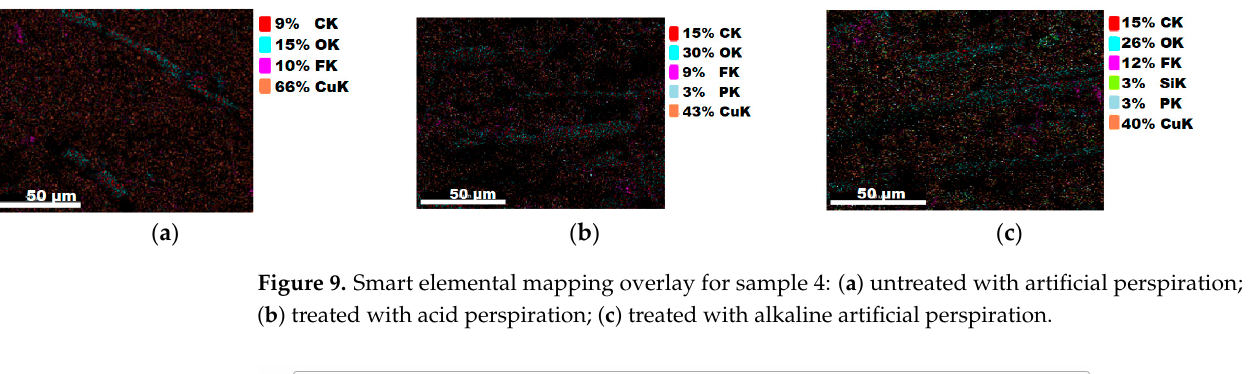
Figure 8. EDS spectra for sample 4 (fabric treated using a preliminary classical cleaning method and conductive paste).